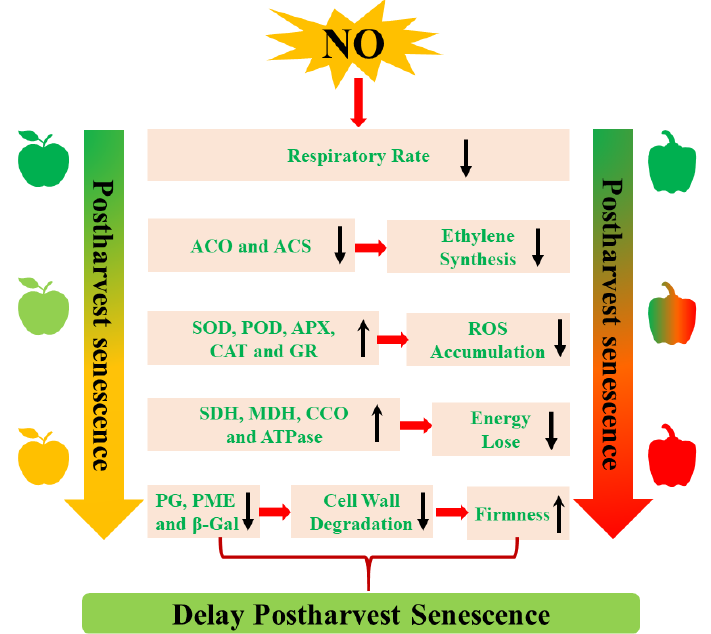
Figure 1. NO-regulated metabolism pathways during postharvest senescence. ACO, 1- aminocyclopropane-1-carboxylic acid oxidase; ACS, 1-aminocyclopropane-1-carboxylic acid synthase; APX, ascorbate peroxidase; CAT, catalase; CCO, cytochrome oxidase; ETH, Ethylene; GR, glutathione reductase; MDH, malic acid dehydrogenase; NO, nitric oxide; PG, polygalacturonase; PME, pectin- methylesterase; POD, peroxidase; ROS, reactive oxygen species; SDH, succinic dehydrogenase; SOD, superoxide dismutase; β -Gal, β -galactosidase. Upward arrow indicates up-regulation; Downward arrow indicates